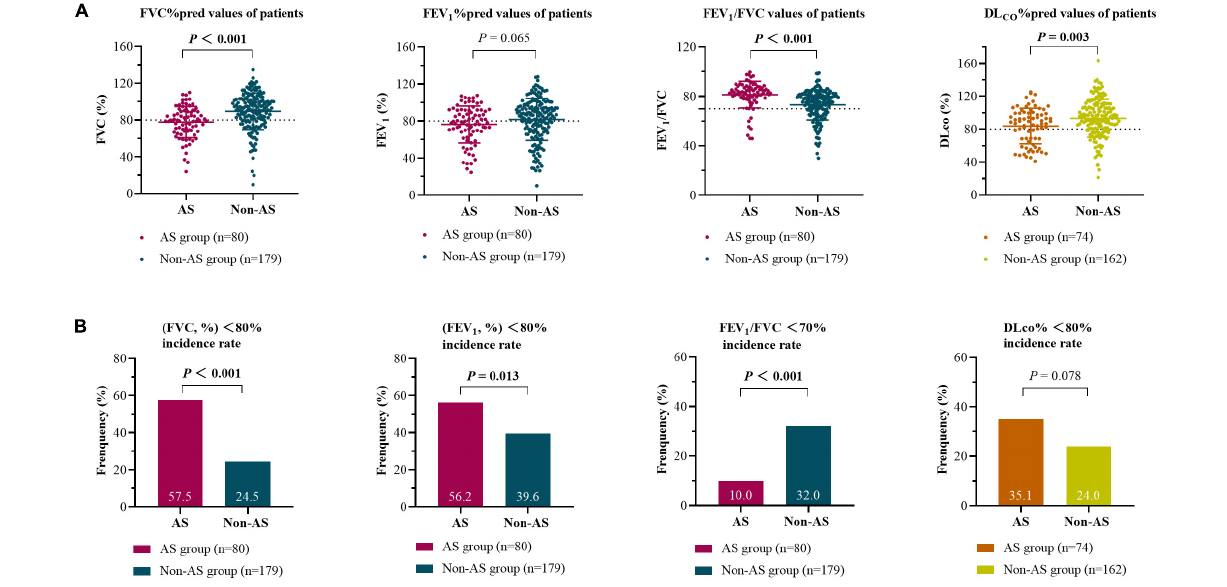
The current or former smokers had statistically lower values of DL CO (%) ( P = 0.022) or tendency of lower FEV 1 values ( P = 0.053) in AS group but not in non-AS group ( Table 2